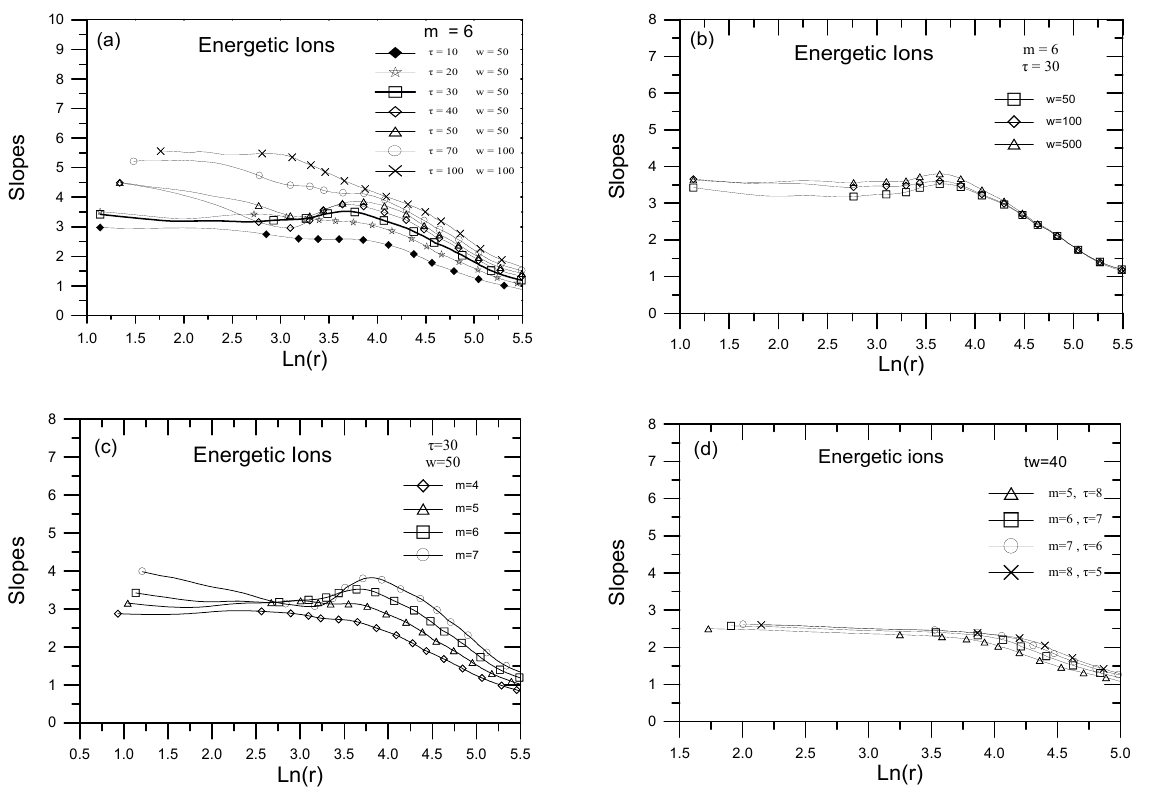
Figure 8 Fig. 8. (a) The slope of the correlation integral as a function of the radius r estimated for embedding m = 6, delay time τ = 10 − 100units of the sampling time and Theiler’s parameter w = 50 , 100. For delay time τ = 20 − 50 we observe the best scaling. (b) The same as (a) but with delay τ = 30 and w = 5500, showing that there is no significant change of the slopes. (c) The same as (a) but with τ = 30, w = 500 and a embedding dimension m = 4 − 7. (d) The same as (c) estimated by using the SVD filtering of the original signal for window length τ w ,w = 50 and independent trajectory matrices for every